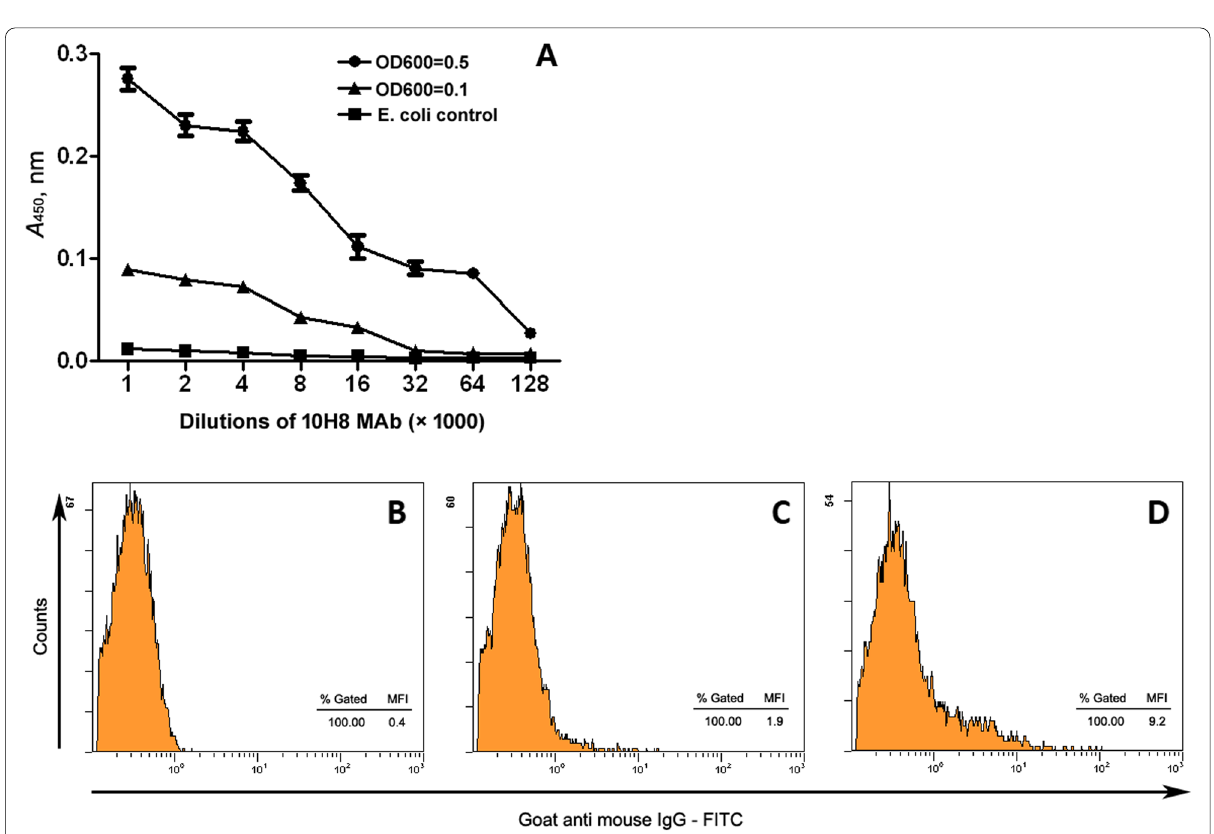
Fig. 4 Surface display of Candida albicans enolase. A Whole cell ELISA showing different dilutions of 10H8 reacted with two C. albicans density (OD600 0.5, OD600 0.1); B – D Extracellular detection of C. albicans enolase by flow cytometry (FCM) analysis. B Mean fluorescence intensity (MFI) = = of the unlabeled C. albicans . C MFI of C. albicans treated with FITC-goat anti mouse IgG. D MFI of C. albicans treated with 10H8 and FITC-goat